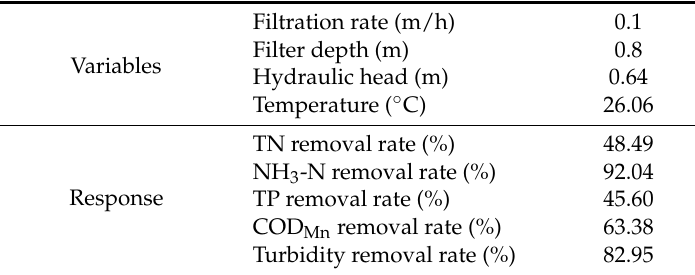
Table 6. Optimum operating parameters of BSF